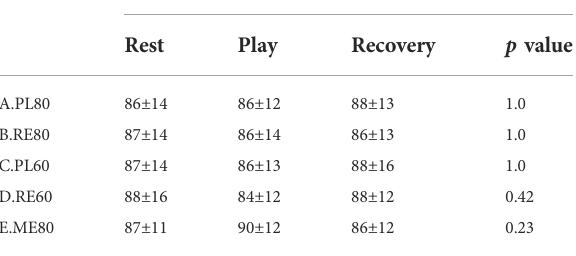
TABLE1Meanbloodpressure(MBP)before,during,andaftertrials.(A) Playing at a fast tempo (PL80), (B) reading music at a fast tempo (RE80), (C) playing at a slow tempo (PL60), (D) reading music at a slow tempo (RE60), and (E) playing without looking at the score (ME). Data are means ± SD and p value for comparing rest vs. during play. No signi fi cant differences were